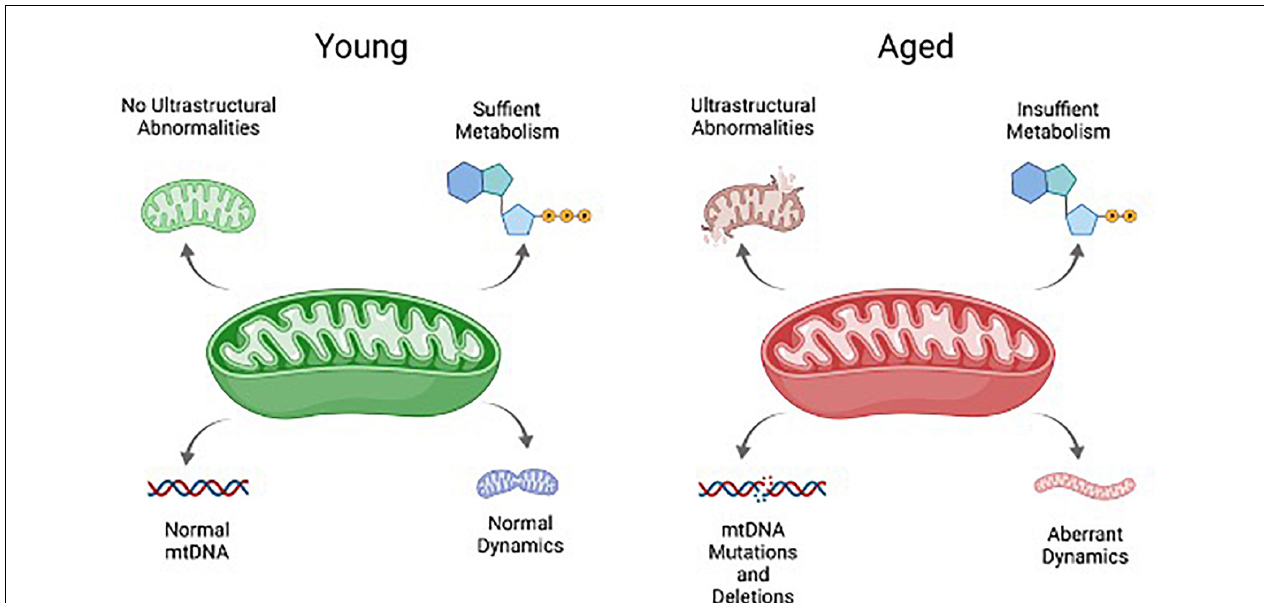
FIGURE 3 | Schematic overview of key mitochondrial characteristics that are negatively impacted by aging. These include mtDNA, mitochondrial ultrastructure and integrity, metabolism, and mitochondrial